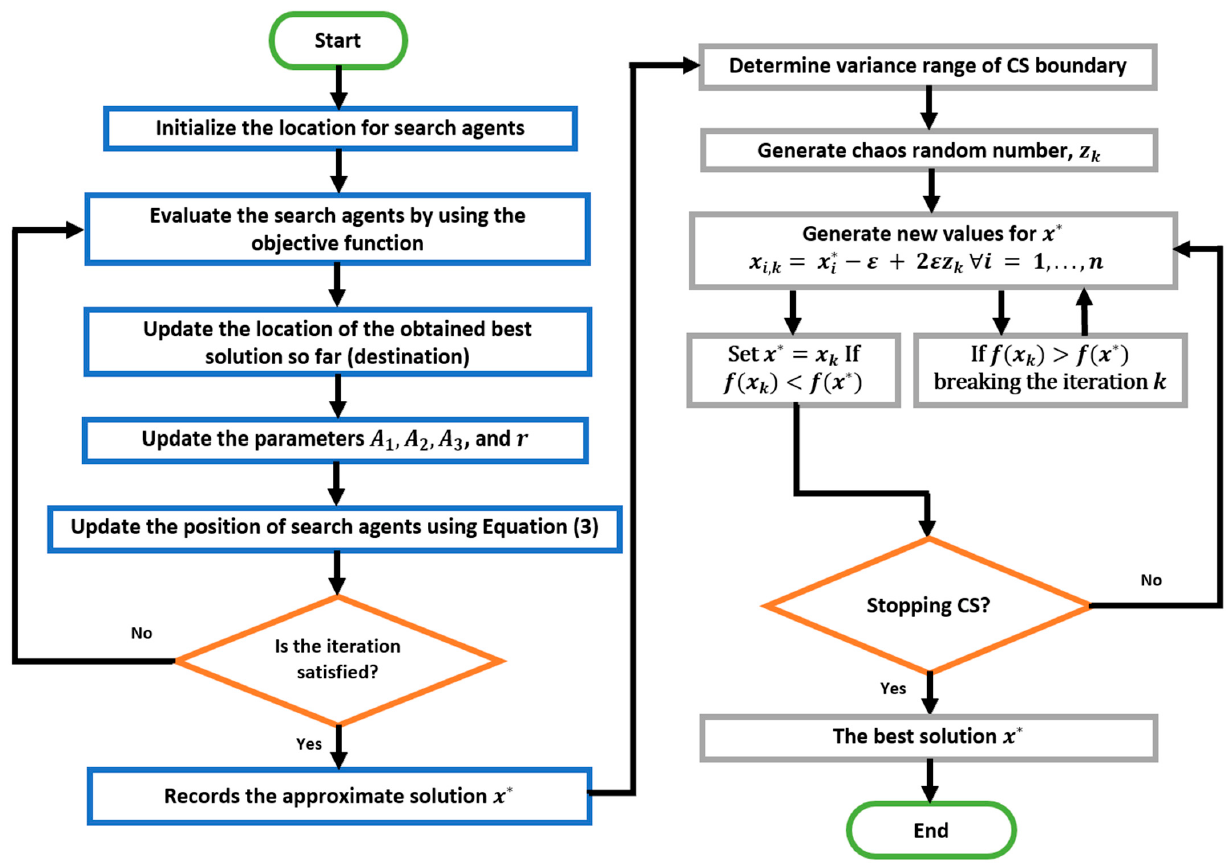
Figure 3. CSSCA’s